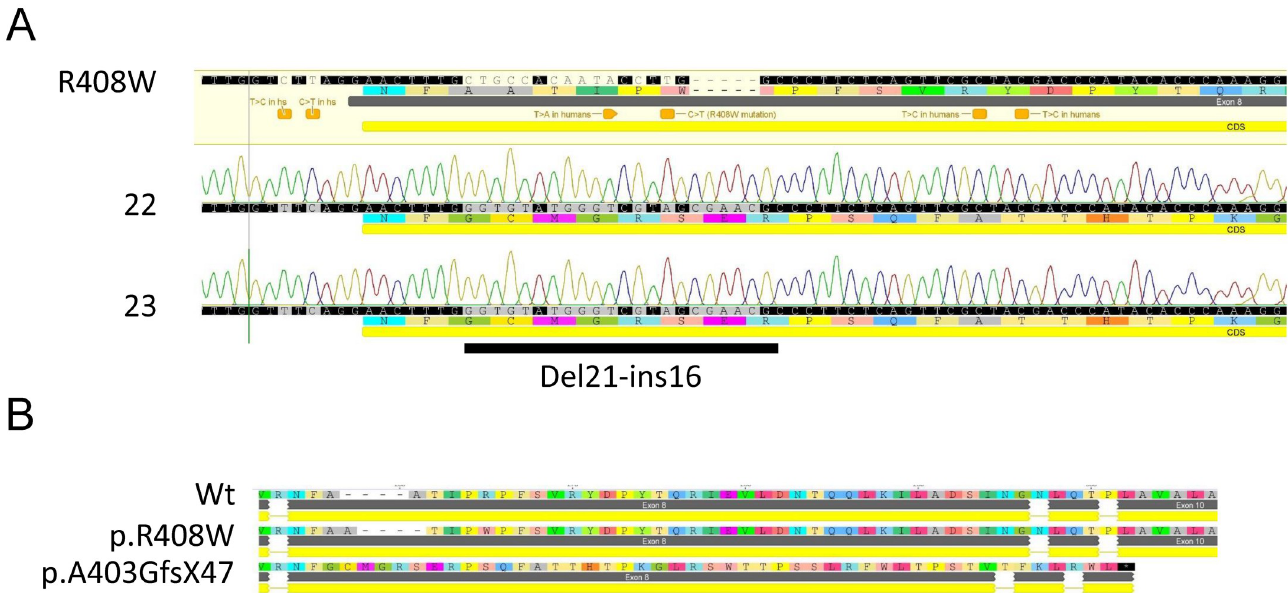
Fig 2. Genotype of compound heterozygous hR408W/pA403GfsX47 pigs. A) Sanger sequencing of TOPO clones from Piglet Nos. 22 (Charm) and 23 (Lucky). Only the non-R408W allele is shown, revealing an indel consisting of a 21 base pair deletion with a 16 base pair insertion. B) Translation of the indel cDNA and alignment the wild type and R408W shows the frame shift mutation begins at amino acid A403 resulting in a stop codon 47 amino acids downstream. This allele does not produce functional PAH, as predicted by this translation.